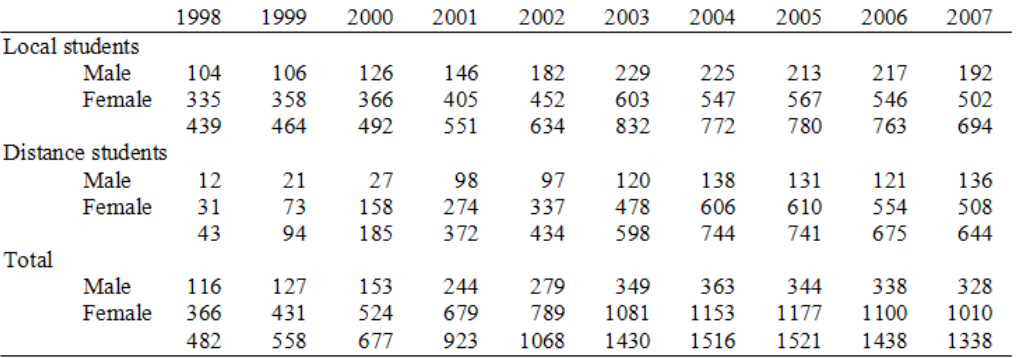
Table 2. Number of students at the University of Akureyri 1998-2006